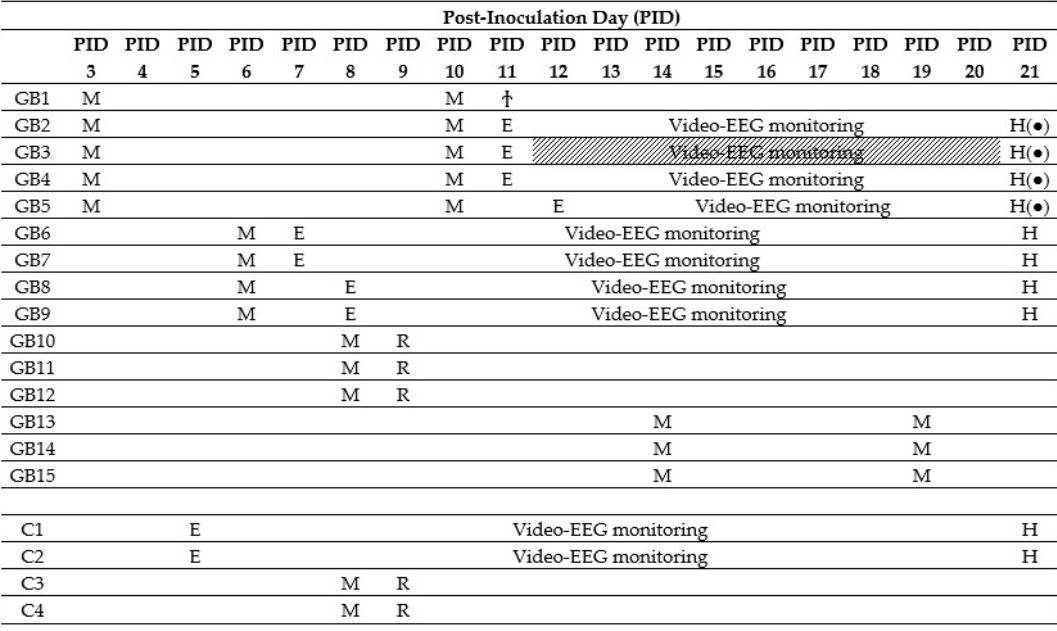
Table 1. Overview of timing of the different procedures per animal. MRI (M) was performed in different animals at different time points. After confirmation of tumor growth, electrodes were implanted (E) in a subset of animals. GB1 died during electrode implantation ( Ϯ ). GB3 was left out for analysis due to bad EEG signals (shaded). Tissue from monitored animals was collected on PID21 for histological analysis (H). Tissue from GB10–12 and C3–4 was collected the day after MRI for RNAscope analysis (R).